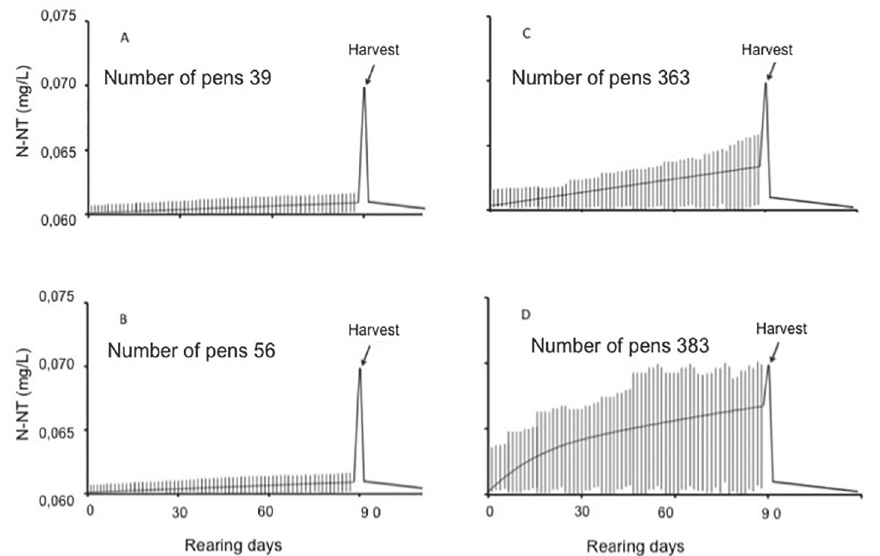
Figure 4 - Influence of the number of pens on total nitrogen concentration at the Porto do Rei bay. A - current velocity of 0.01m s -1 and net clogging effect of 40%; B - current velocity of 0.01m s -1 and net clogging effect 20%. C and D - current velocities of 0.02 and 0.035m s -1 , respectively, and net clogging effect of